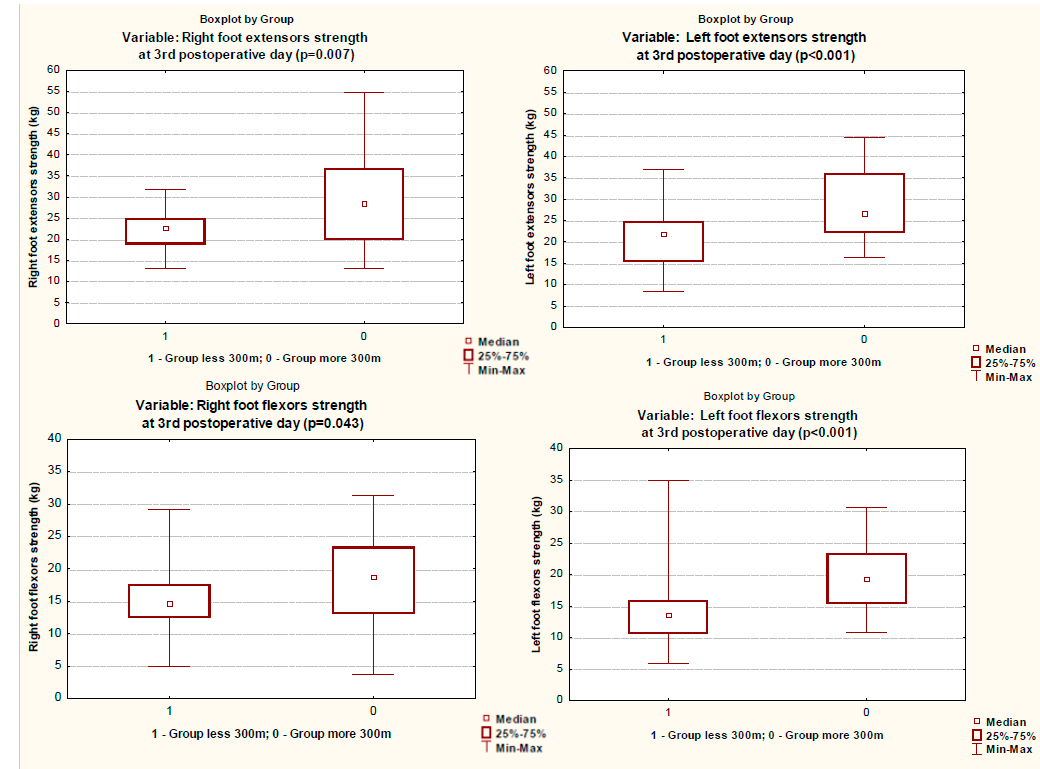
Int. J. Environ. Res. Public Health 2022 , 19 , x FOR PEER REVIEW Figure 3. Foot extensor and flexor strength in groups on 3rd postoperative day.